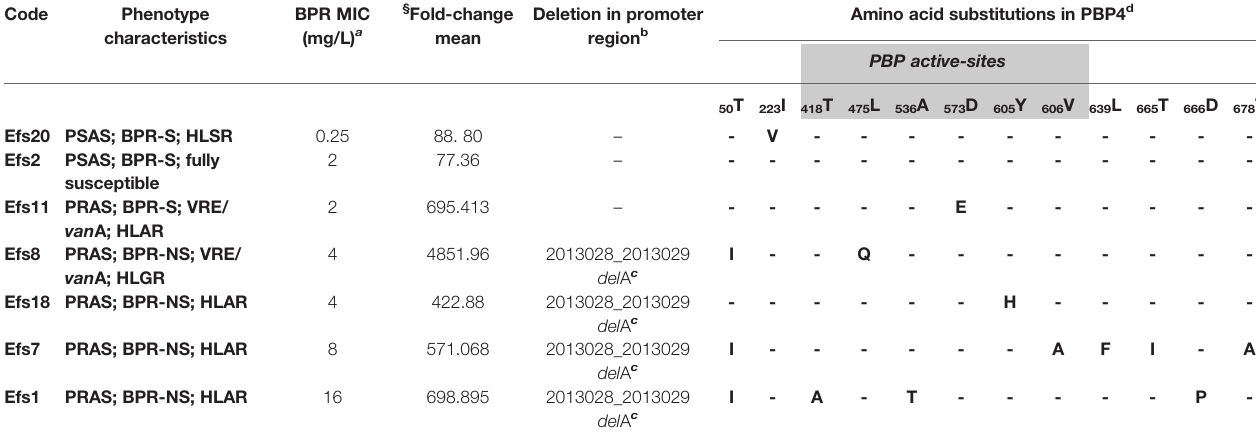
TABLE 2 | Ceftobiprole MIC values (mg/L) and expression levels for E. faecalis clinical isolates, compared to sequence alterations. Code